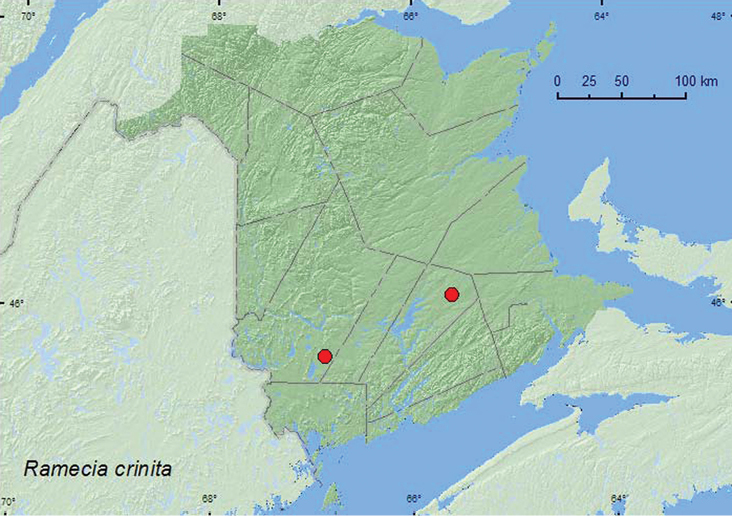
Collection localities in New Brunswick, Canada of Ramecia crinita.